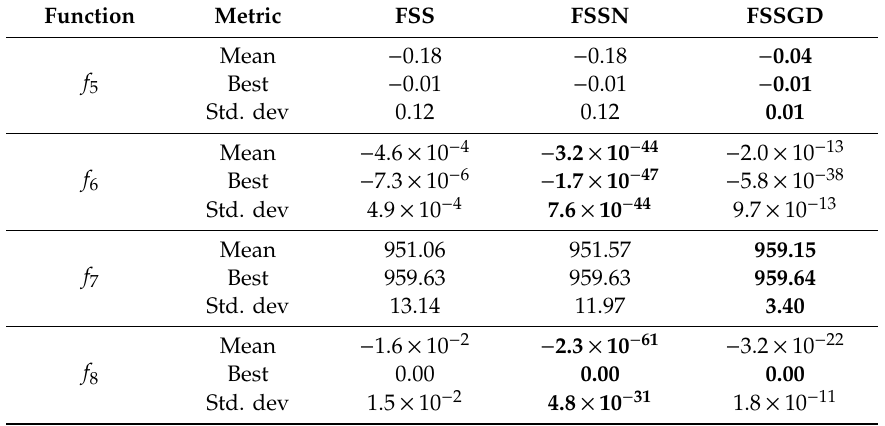
Table 3. Accuracy comparison of the algorithms optimizing 2-dimensional functions from Table 1.